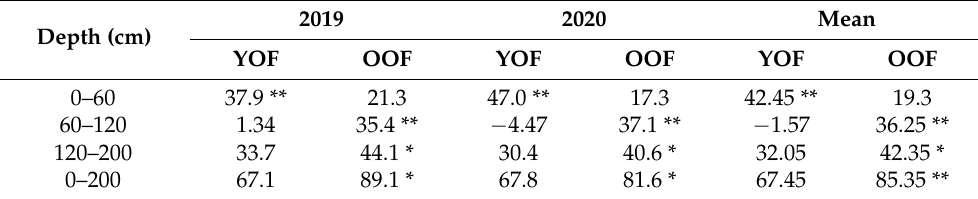
Table 4. NO 3 − -N accumulation (kg · hm − 2 ) in different soil layers in the YOF and OOF. Depth